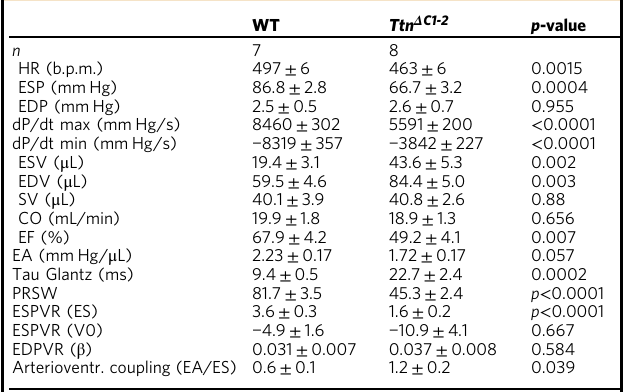
Table 2 Pressure (P) – volume (V) analysis of the left ventricular chamber of the heart